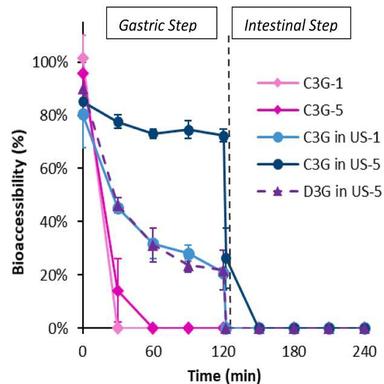
Bioaccessibility of C3G and D3G during the in vitro simulated gastrointestinal digestion of phospholipid-stabilized emulsions in the presence of metmyoglobin (30 µM) and the DJP-US extract or pure C3G. Values represent mean ± SD (n = 3).